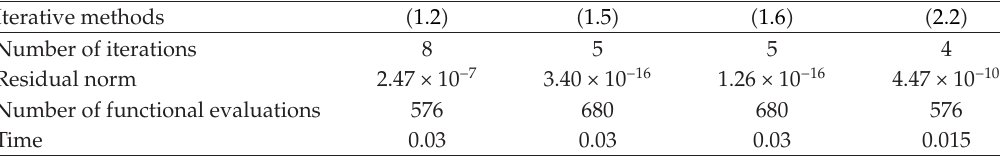
Table 4: Results of comparisons for di ff erent methods in Example 5.3 when n (cid:4) 8. Iterative